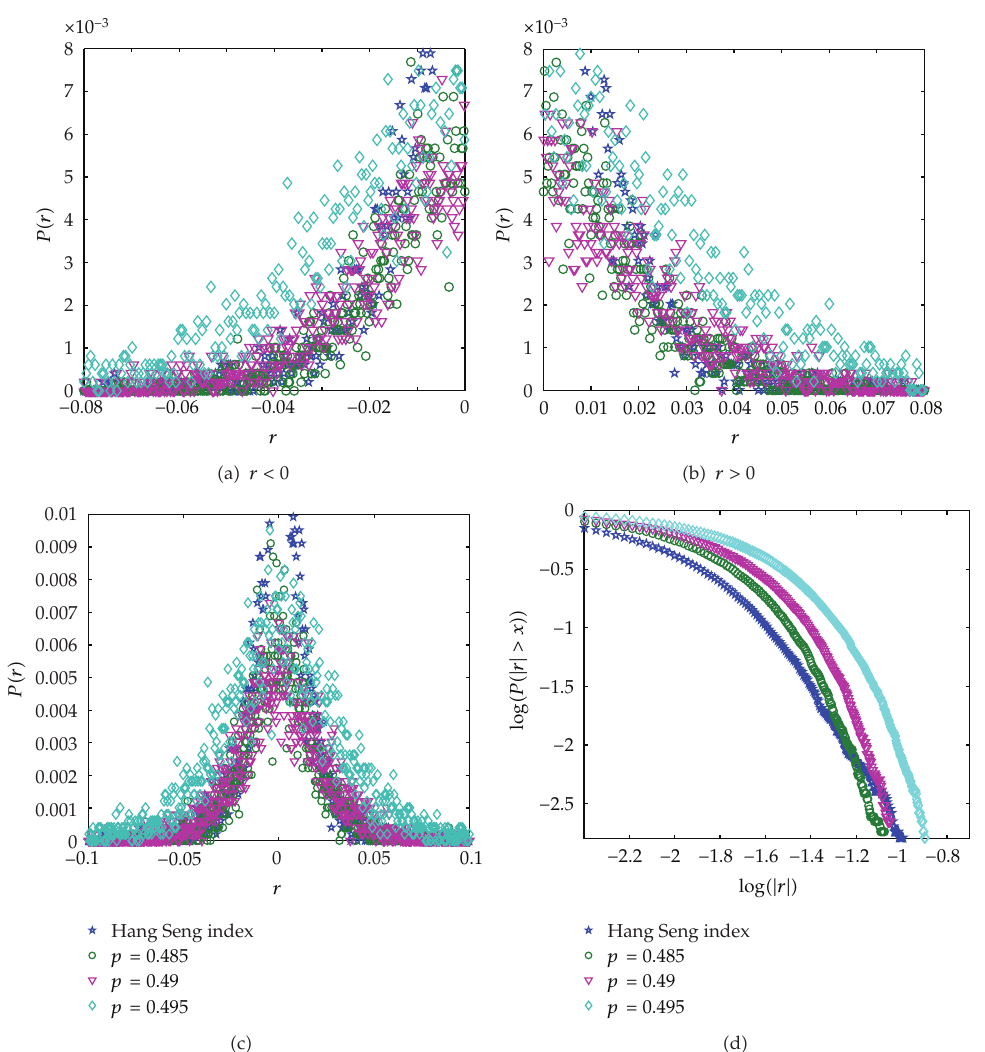
Figure 3: The plots (cid:2) a (cid:5) , (cid:2) b (cid:5) , and (cid:2) c (cid:5) are the probability distributions of the logarithmic returns, and the plot (cid:2) d (cid:5) is the cumulative distributions of the normalized price returns. The data is selected from Hang Seng Index and from the simulation data with the di ff erent values p , p (cid:6) 0 . 485, p (cid:6) 0 . 49 and p (cid:6) 0 . 495. where